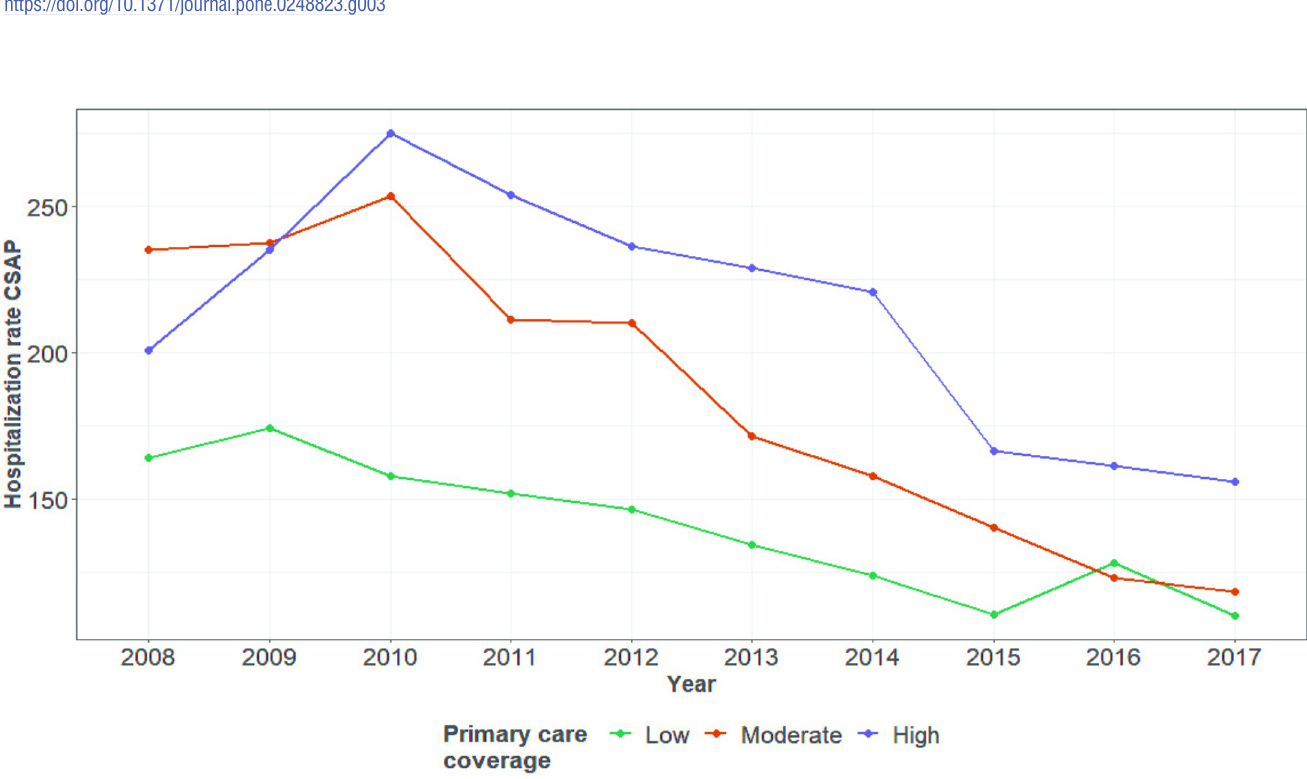
Fig 4. Evolution of the rate of hospitalizations for ambulatory care-sensitive conditions per coverage class in Para´, 2008–2017. Source: SIH; CNES/DATASUS.